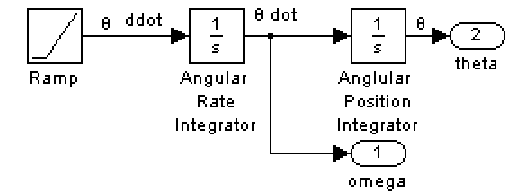
Figure 7. Calculation of optimum states (Ramp = − 12t + 6).